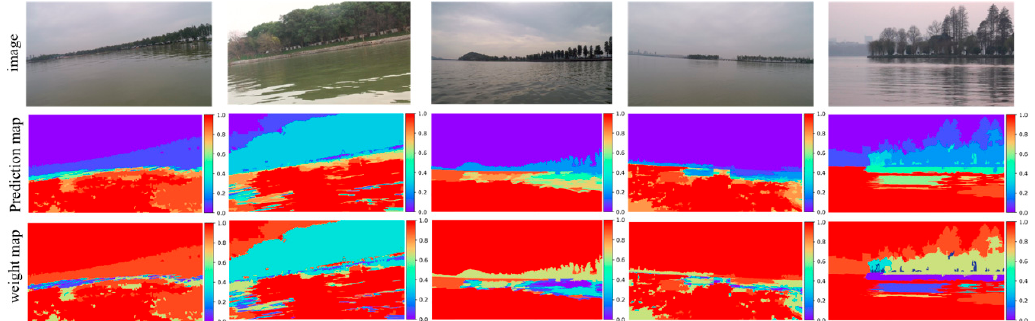
Figure 5. Water region prediction and weight map generating.